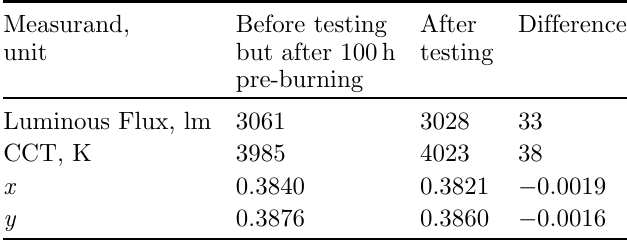
Table 3. Resulting characteristics of the pre-burned DUT (ID VSL085) before and after the